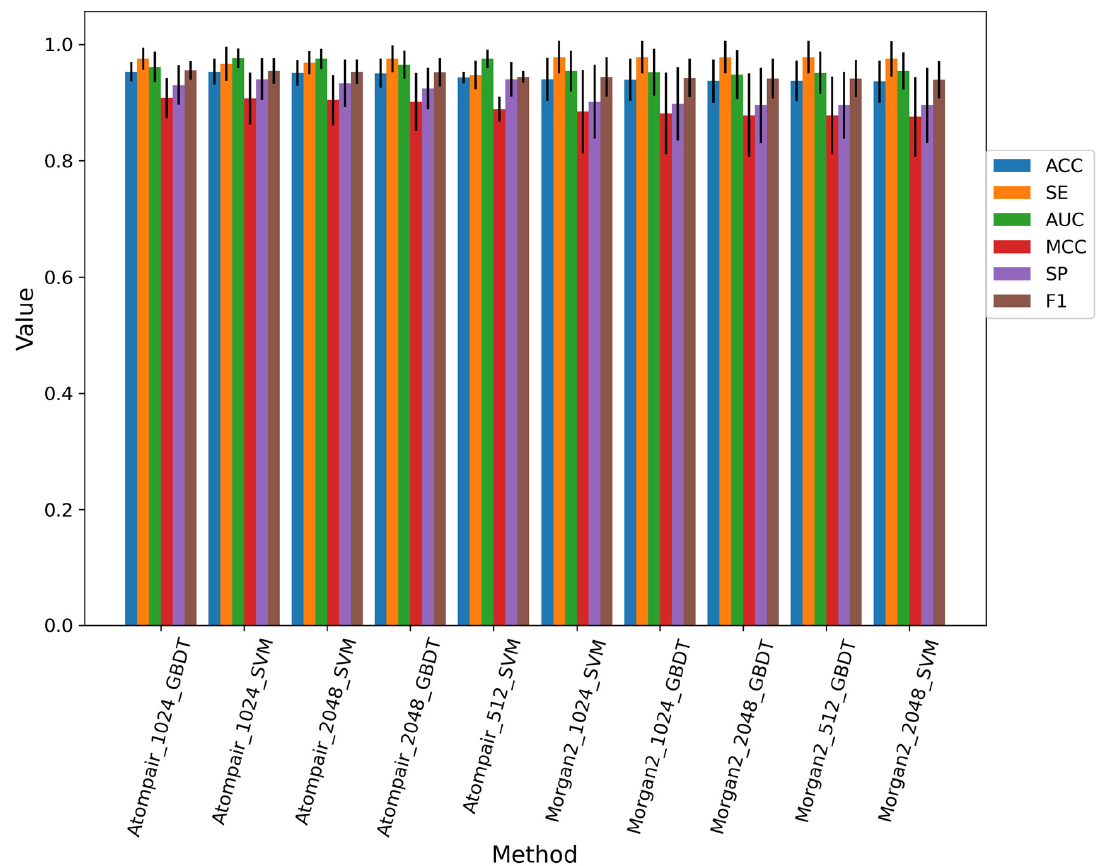
Figure 3. Performance of top 10 baseline models for the fingerprint-based method on the training dataset.